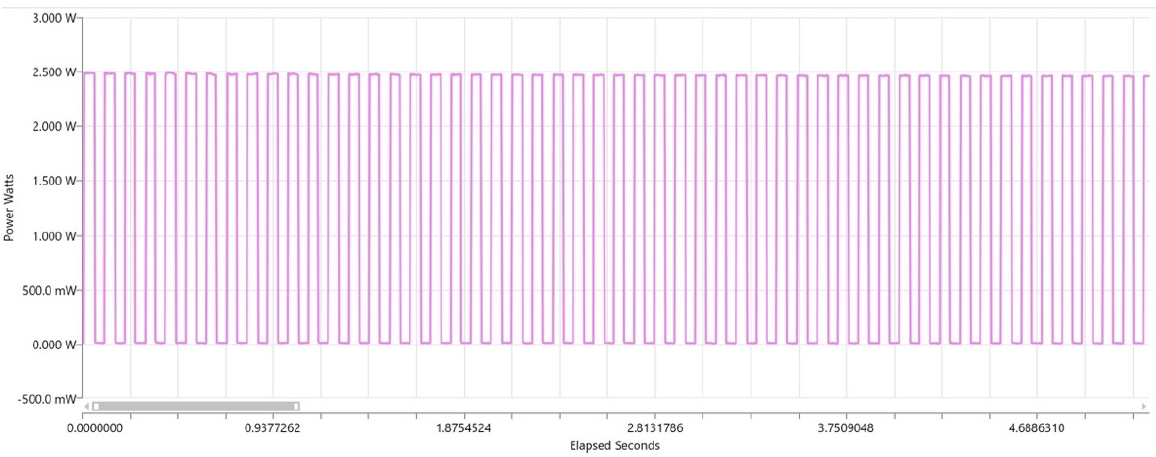
Figure 5. Representative power output of SIROLaser Blue (970 nm) in pulsed mode over 5 s.